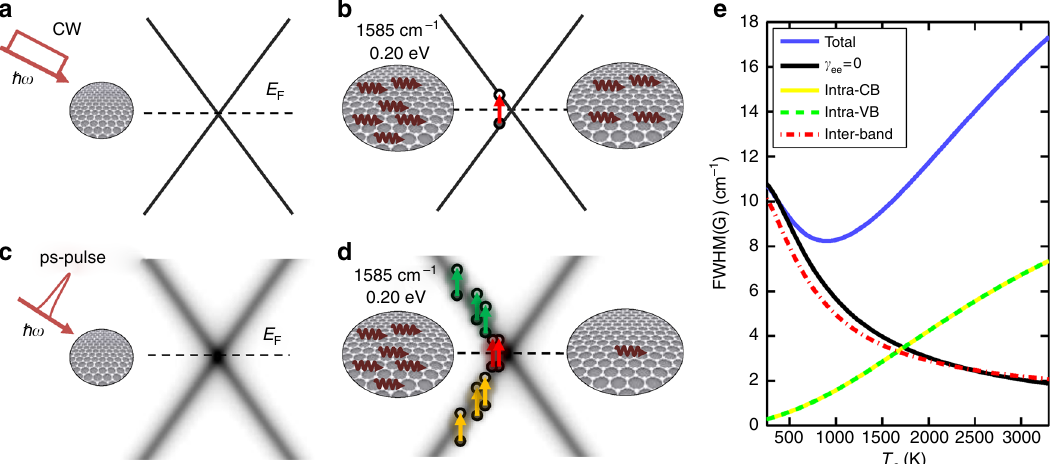
Fig. 4 Effect of Dirac cone broadening on Raman process. a CW photoexcitation with mW power does not affect the Dirac cone. b Accordingly, e – h formation induced by e – ph scattering only occurs in presence of resonant ph excitation. c Under ps excitation, with average P L comparable to a , the linear dispersion is smeared by the large k B T e ≈ ħ ω G = 0.2 eV. d Consequently, e – h formation is enhanced by the increased ph absorption cross section, due to new intra-band processes. e Corresponding contributions to FWHM(G) for the broadened inter-bands and intra-band processes for α e k B = 0.51 cm − 1 K −